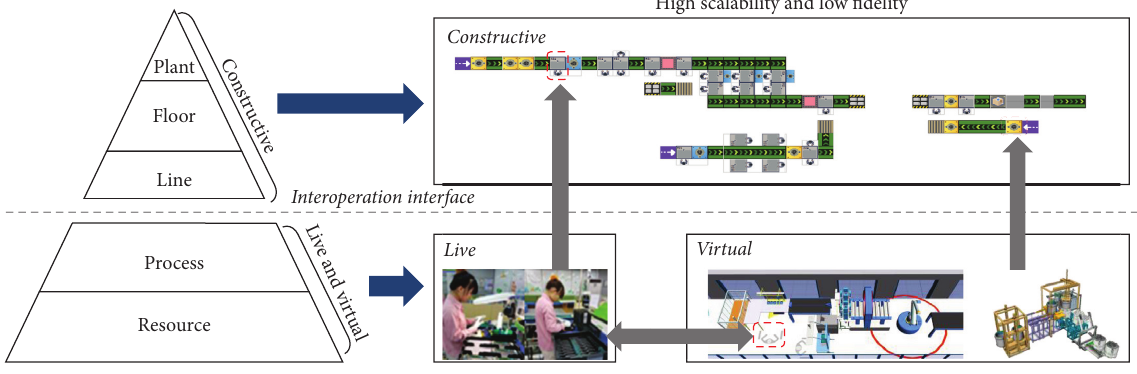
Figure 9: LVC interoperation